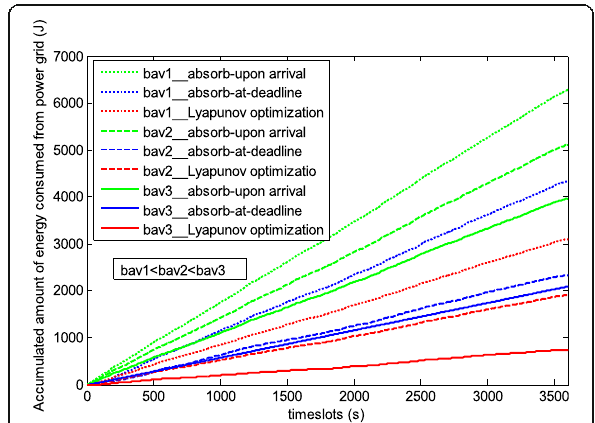
Fig. 5 Comparison of accumulated amount of energy consumption from power grid using three strategies (average amount of energy harvested b av : b av1 ≤ b av2 ≤ b av3